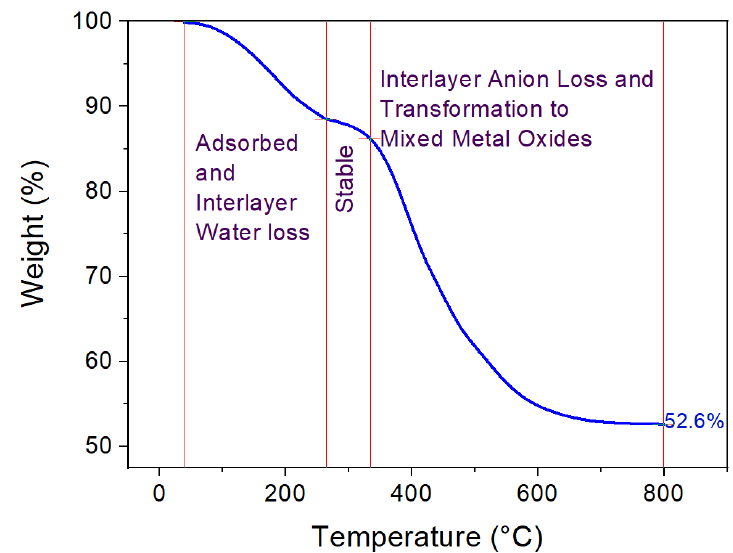
Figure 5. Results from the TGA analysis of uncalcined LDH.